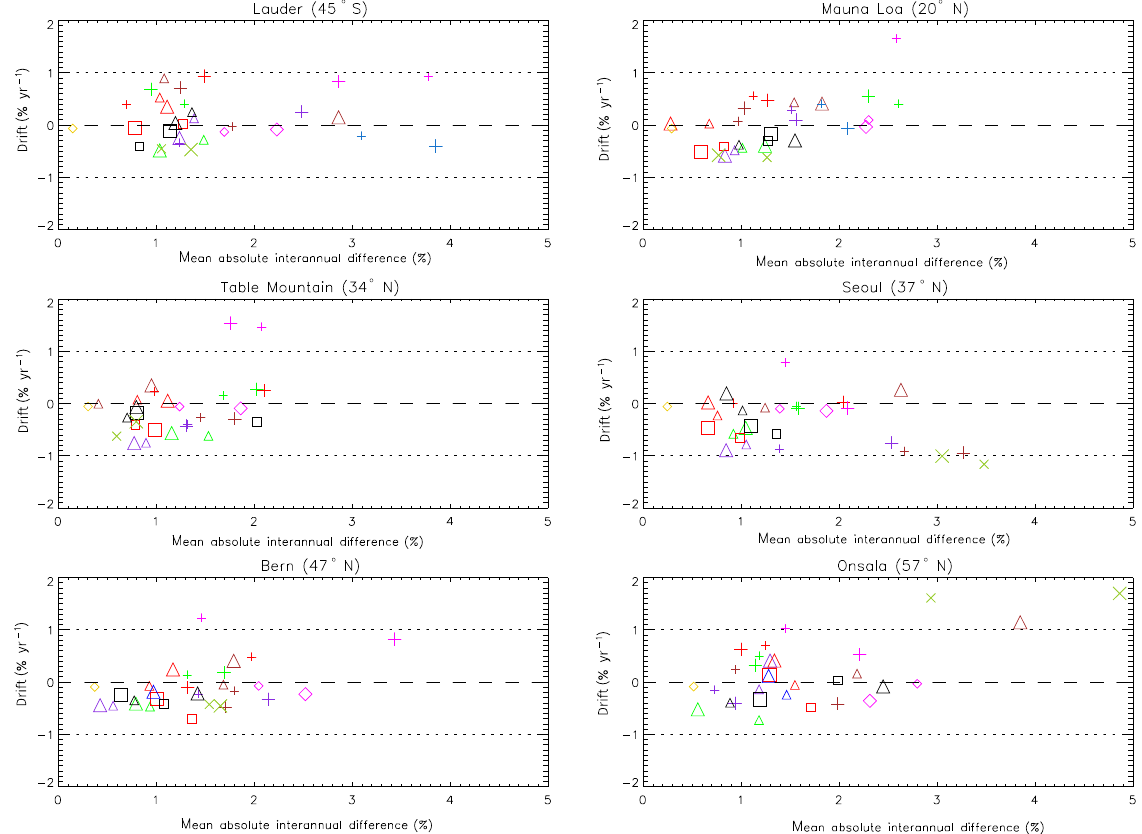
Figure 6. The drift ( y axis) and mean absolute interannual difference ( x axis) between coincident H 2 O measurements at 0.46hPa. Results are shown at six ground-based sites and, unless otherwise indicated, all differences are with respect to MLS measurements at those sites. The large symbols indicate differences for coincident comparisons, as were shown in Fig. 2. The small symbols indicate comparisons of annual average differences from climatologies (see text for details). The symbols used are from Fig. 1 and indicate the instrument that is being compared with MLS. The MLS symbol shows the results of comparisons between convolved and unconvolved MLS measurements. The overlap period between HALOE and MLS is too short for these analyses, but we do perform these analyses for GBMW vs. HALOE comparisons at Lauder and Mauna Loa. These are indicated using the HALOE symbols from Fig.